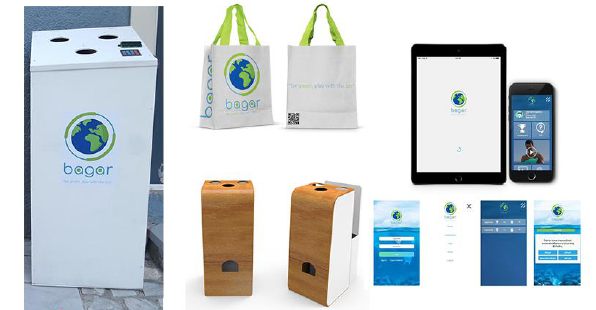
Figure 3. Bagar: Prototype, Cloth Bag, Mobile Application